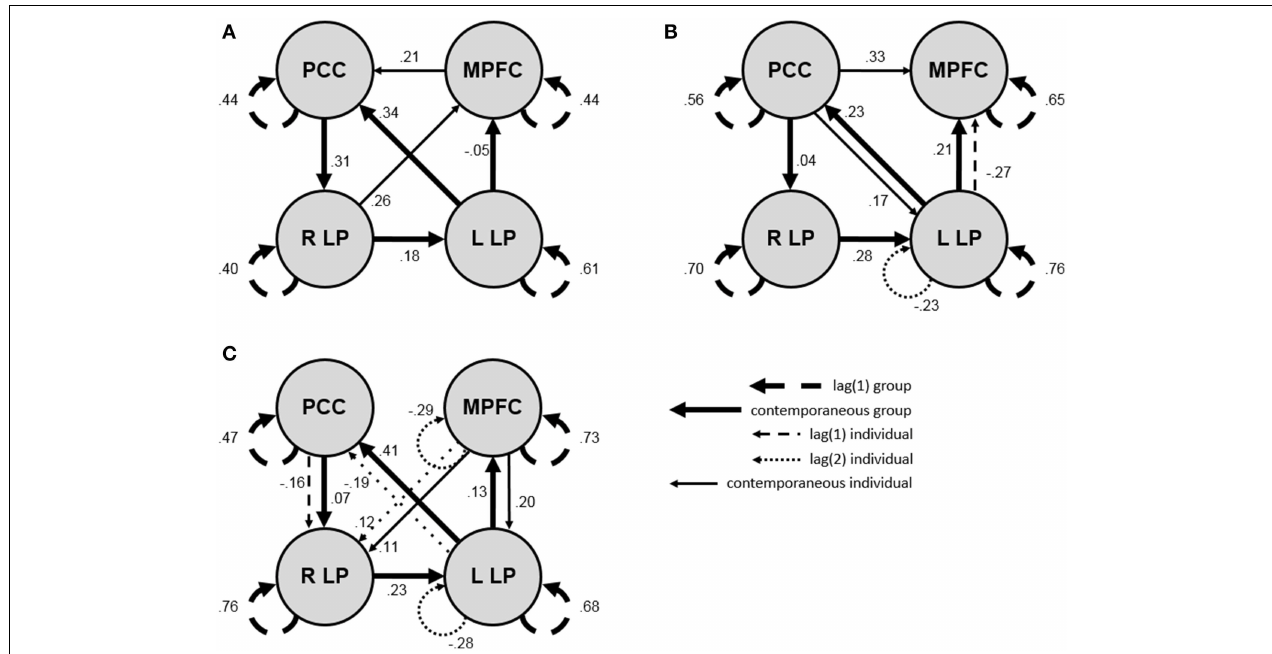
FIGURE 4 | Exemplar final directed functional connectivity maps from GIMME analysis and a posteriori model validation of a 32-subject resting state data set. Thick lines reflect group-level connections, thin lines reflect individual-level connections, dashed lines reflect first order connections, dotted lines reflect second order connections, solid lines reflect contemporaneous connections, and values show connection strengths (i.e., beta-weights; all are significant at p = 0 . 05 except for group paths ≤ |0.13|). (A) Final map for a subject requiring only the lag one and contemporaneous connections estimated in GIMME; the map fit the data well [ χ 2 (12) = 17 . 40 , p > 0 . 05 , RMSEA = 0.05, SRMR = 0.04, CFI = 0.99, NNFI = 0.98] and contained white noise residuals [ χ 2 (126) = 136 . 94 , p > 0 . 05 , RMSEA = 0.00, SRMR = 0.10,